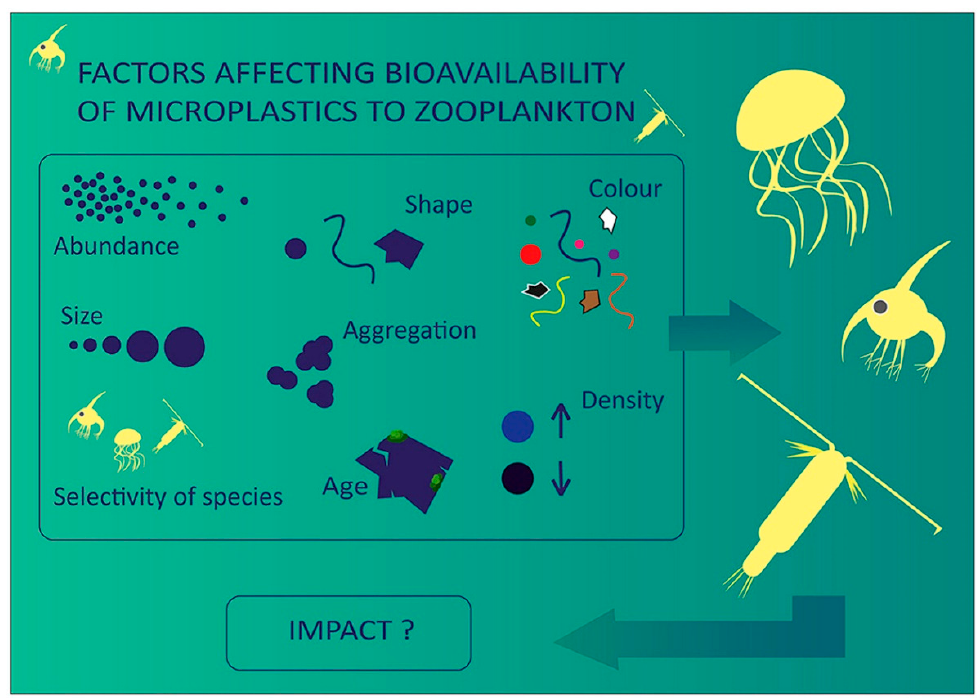
Figure 1. Microplastics are a suite of contaminants. Figure from Botterell et al. 2019 [10]. Open Ac ‐ cess.